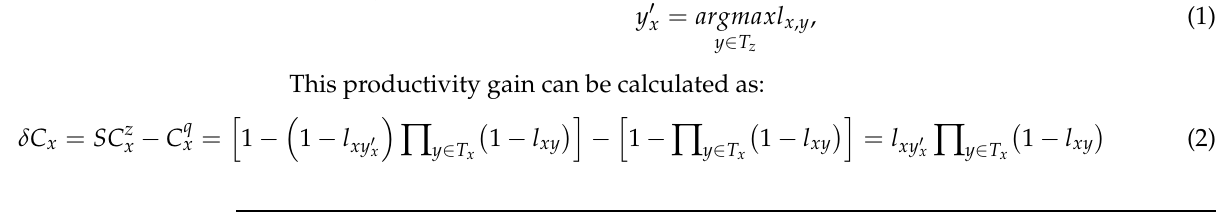
Algorithm 1 Unshared